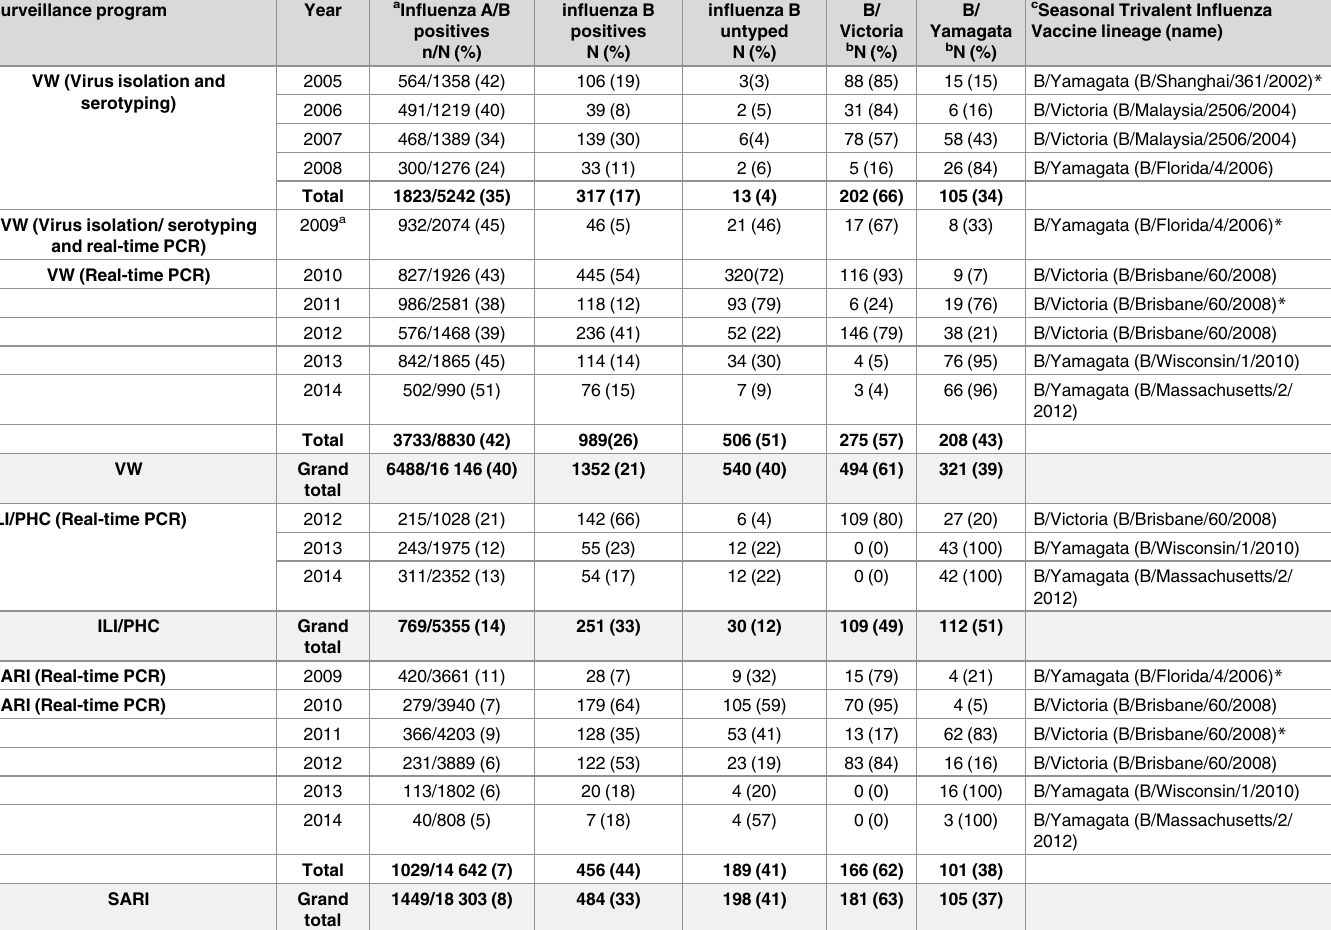
Table 1. Detection rates for influenza viruses in the three surveillance program, Viral Watch (VW), Illnesses-like influenza surveillance in public health clinics (ILI/PHC) and severeacute respiratory illnesses (SARI) in South Africa, 2005–2014. Surveillance